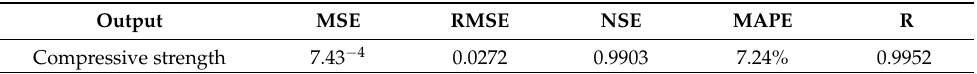
Table 7. Comparison of five statistical measures to validate the performance of the MLP network. Output MSE RMSE NSE MAPE R Compressive strength 7.43 − 4 0.0272 0.9903 7.24% 0.9952